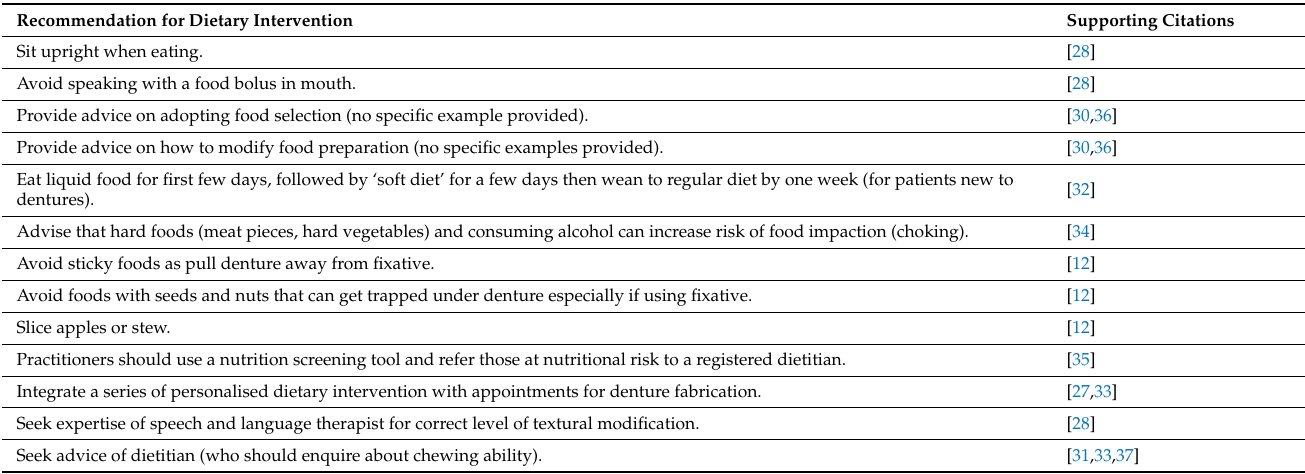
Figure 1. PRISMA flow chart.